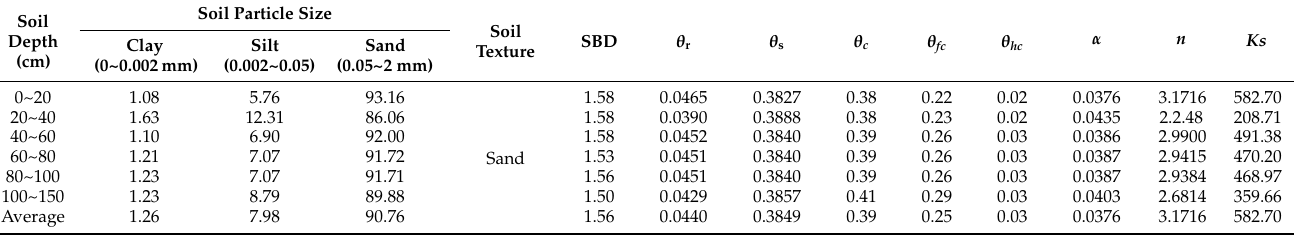
Table 2. Basic physical parameters of